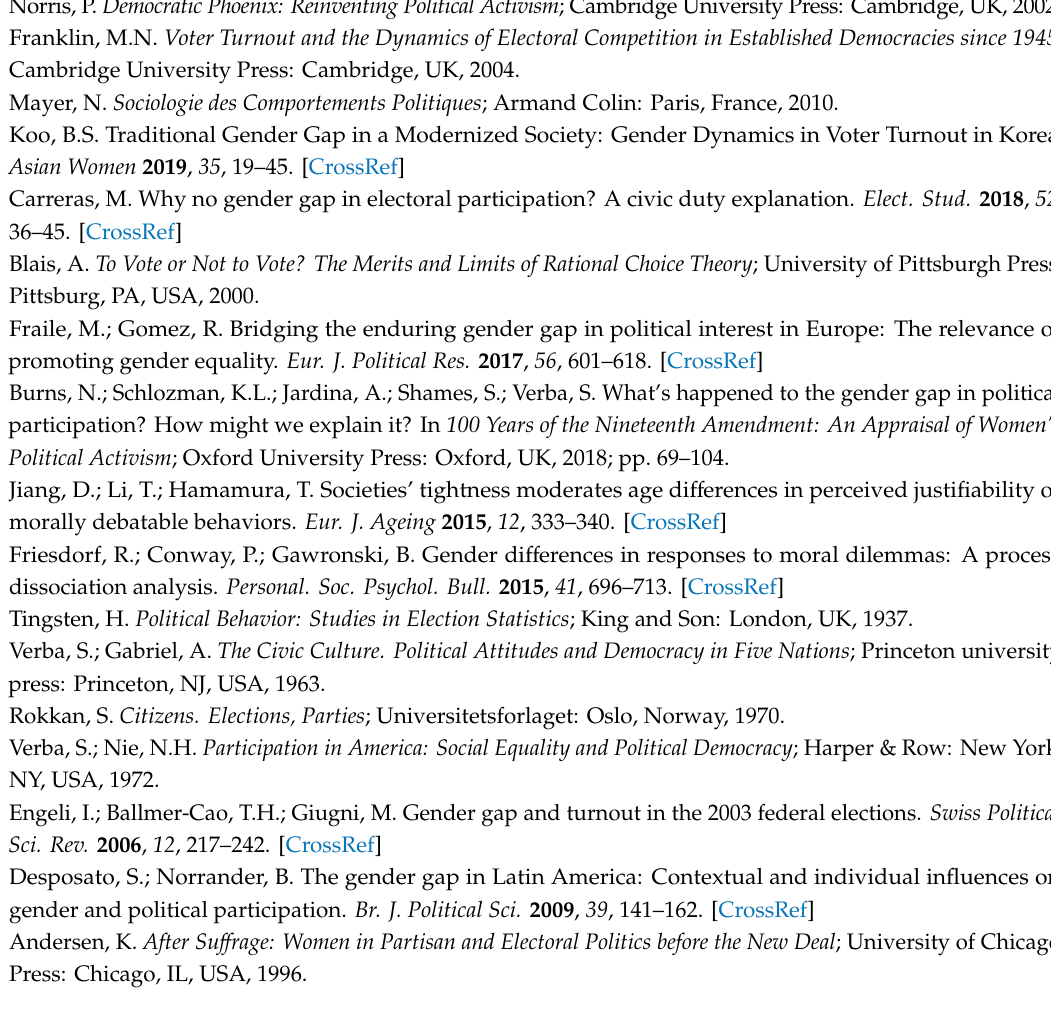
Figure A2. Percent of dutiful citizens and women per country